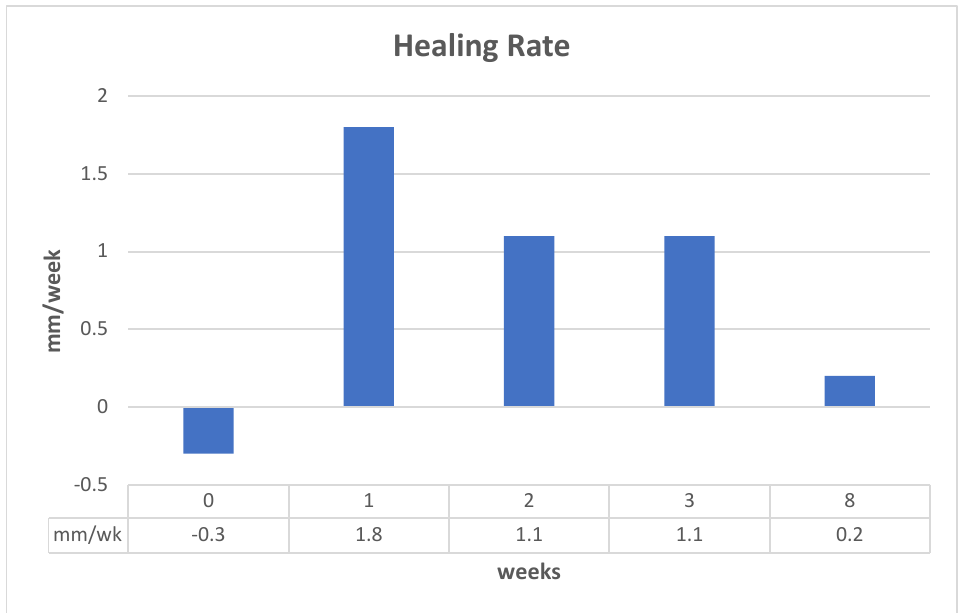
Figure 12. The overall healing rates (mm/wk) of the patients. The values are seen on the left-hand scale as well as included at the bottom of the chart. The values are for the specific time period. Pre-treatment and post-treatment are 0, 1 wk is the first week after treatment began, 2 wk is between 1 and 2 weeks, 3 wk is between weeks 2 and 3, 8 wks are between weeks 3 and 8.